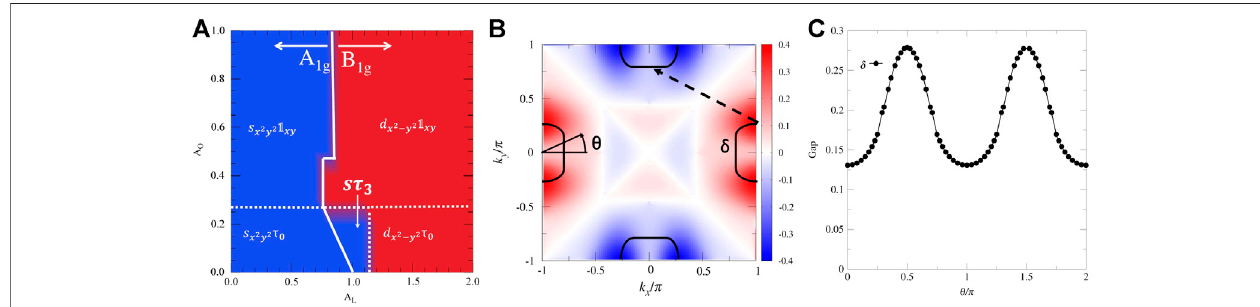
FIGURE6|(A) Pairingphase diagramofthemultiorbital t - J modelforalkaline ironselenides. Theblueshadedareacorrespondstodominant pairingchannelswith an s x 2 y 2 form factor while the red shading covers those with a d x 2 − y 2 form factor. The continuous line separates regions where the pairing belongs to the A 1 g and the B 1 g representations, respectively. The orbital-selective s τ 3 pairing occurs for A O < 1, A L near 1. (B) The Fermi surface (solid line) and the sign-change intraband pairing function of the corresponding band for the alkaline iron selenides. The dashed arrow indicates the q (cid:2) ( π , π / 2 ) wave-vector associated with the spin resonance found in experiment. (C) Superconducting gap along the electron pocket. In (B) and (C) the dominant s τ 3 pairing state is stabilized with parameters J 2 (cid:2) 1 . 5, A O (cid:2) 0 . 3, and A L (cid:2) 0 . 9, adapted from